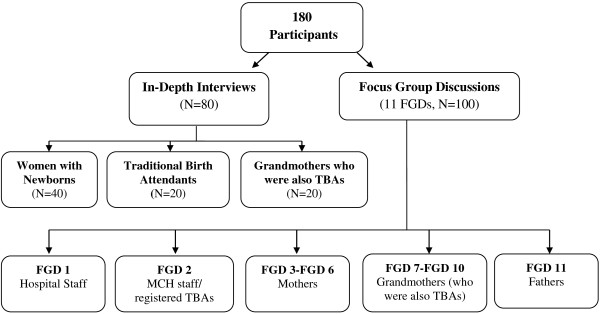
Sampling design.